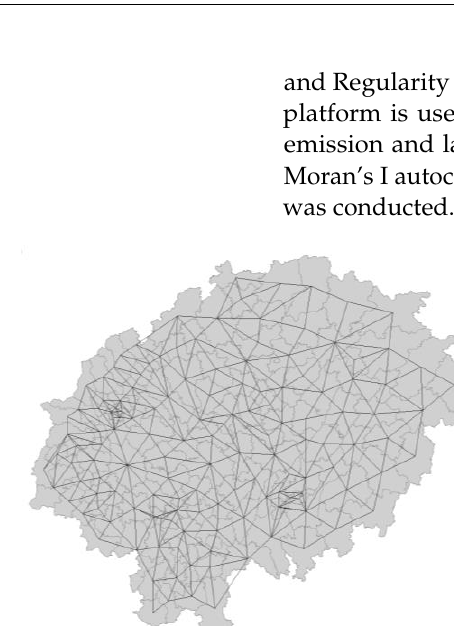
Figure 10. Moran’s I scatter diagram of carbon emissions and information entropy of land use structure in 2015. The spatial clustering of carbon emissions in the Sichuan basin may be due to two reasons: (i) the geographical development has the characteristics of a growth pole nu- cleus, that is, the rapid development of a certain point will drive the development of ad- jacent surrounding areas; (ii) the unique financial decentralization and local political system in China, which prompt localities to increase their input in some areas, and so the intensity of carbon emissions emission is relatively concentrated. The spatial clustering of the information entropy may also be due to two reasons: (i) administrative districts within the same geographical unit have similar land-use patterns; (ii) neighboring sam- ple units have similar policies and anthropogenic activities in response to conditions such as construction land and natural resources. 3.2.2. Model Selection In this study, spatial econometric analysis was performed in the Stata platform. The panel data of land-use structure information entropy and carbon emissions in five peri- ods were analyzed: ① Lagrange Multiplier (LM) test, the p -value of both the SEM model and SLM model were significant at 1% level, and the SDM model combining both could be selected in this study; ② Hausman test, the results passed the 1% significance level test, and the fixed effect model was better than the random effect model in this study; ③ Likelihood ratio (LR) test, the original hypothesis of degrading the SDM model into SLM